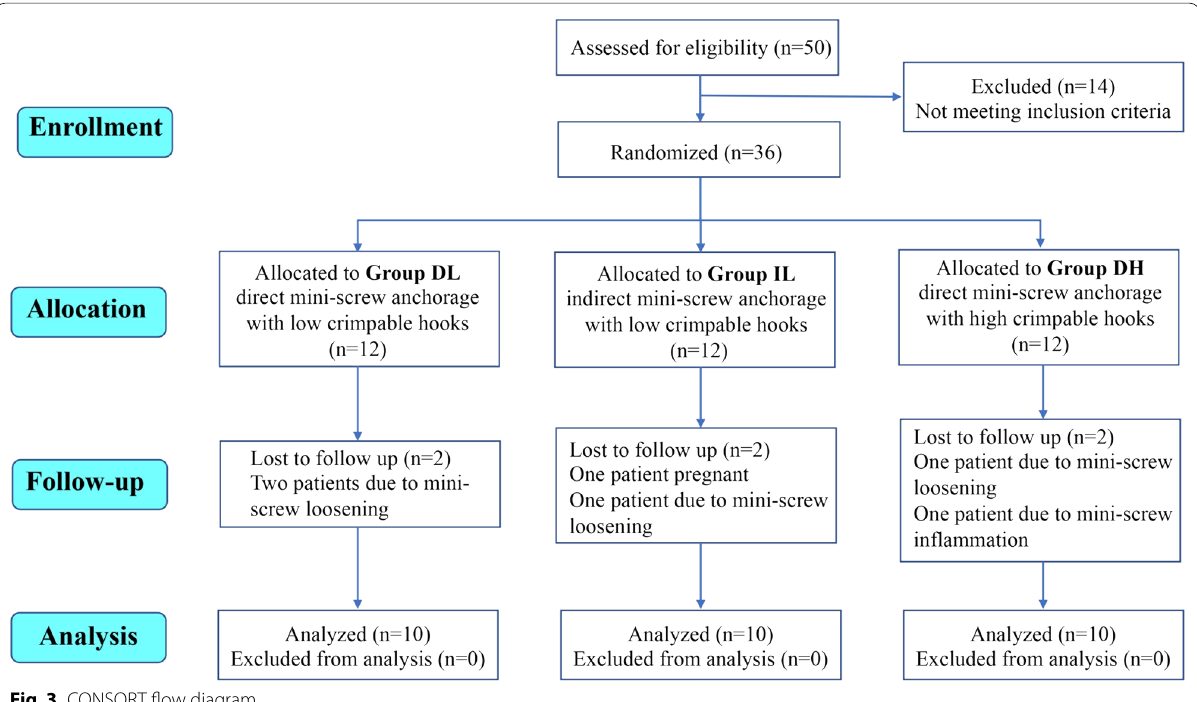
Fig. 3 CONSORT flow